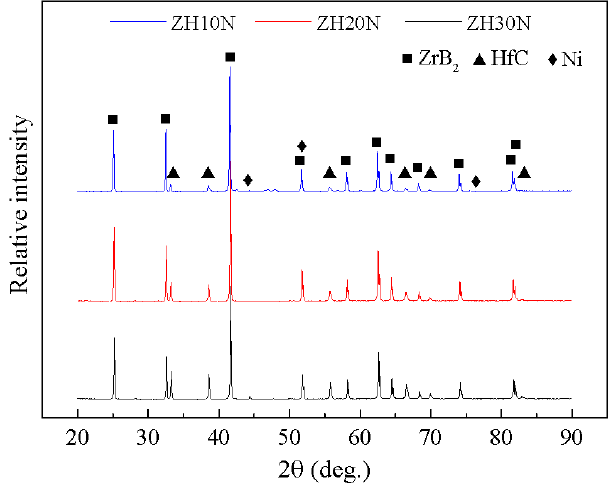
Figure 1. X-ray diffraction (XRD) patterns of ZrB 2 –HfC ceramics.